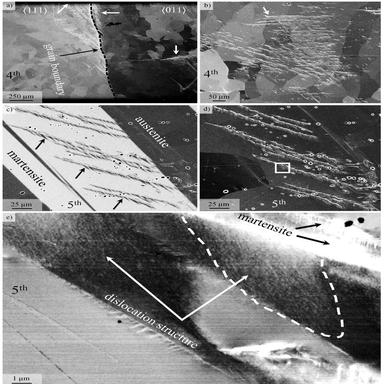
Microstructure of the tensile oligocrystalline specimen. (a) SEM micrograph in BSE contrast of 〈111〉 and 〈011〉 oriented grains including the grain boundary obtained after the fourth loading cycle up to εmax = 4.5%. Arrows indicate regions with retained martensite. (b) Retained martensite in the 〈011〉 oriented grain. (c) Martensitic band (bright contrast) with austenitic zig-zag structure (dark contrast; marked by black arrows) at maximum load during the fifth loading cycle. (d) Pinned martensite after unlo